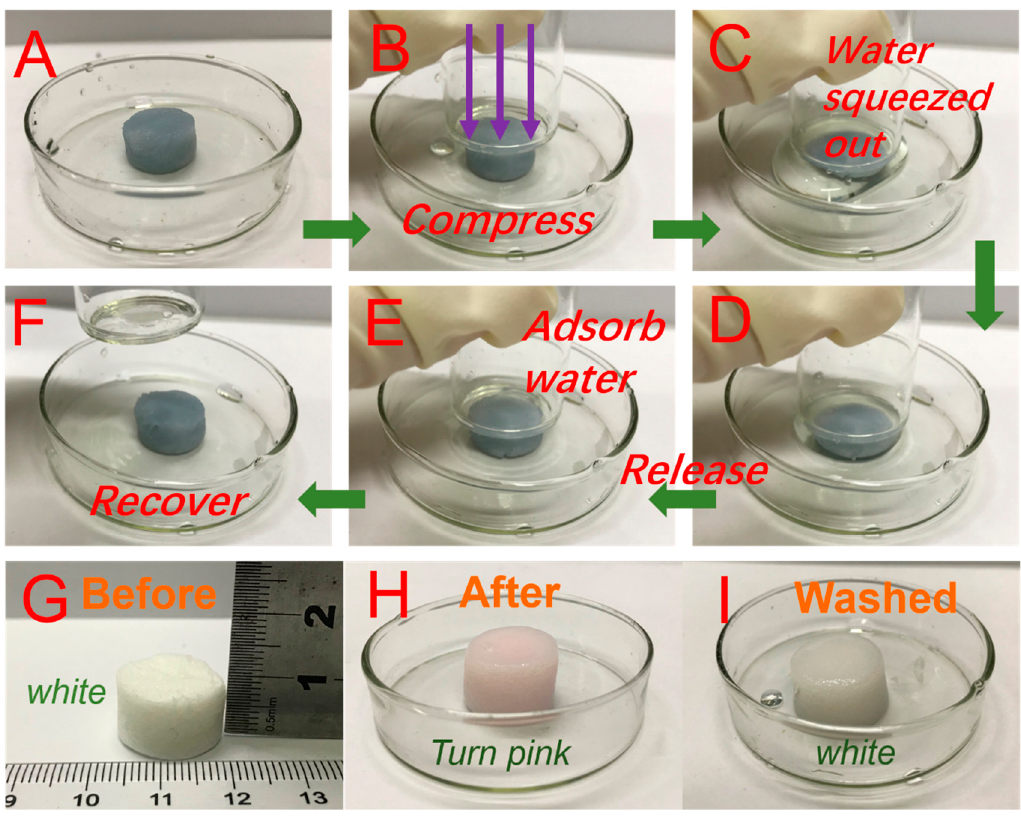
Figure 7. ( A – F ) The adsorption process for heavy metal ions of the U -EDTA CCA; ( G ) geometric size of the U -EDTA CCA; ( H ) U -EDTA CCA loaded with Co 2+ ; and ( I ) image of the regenerated U -EDTA CCA.